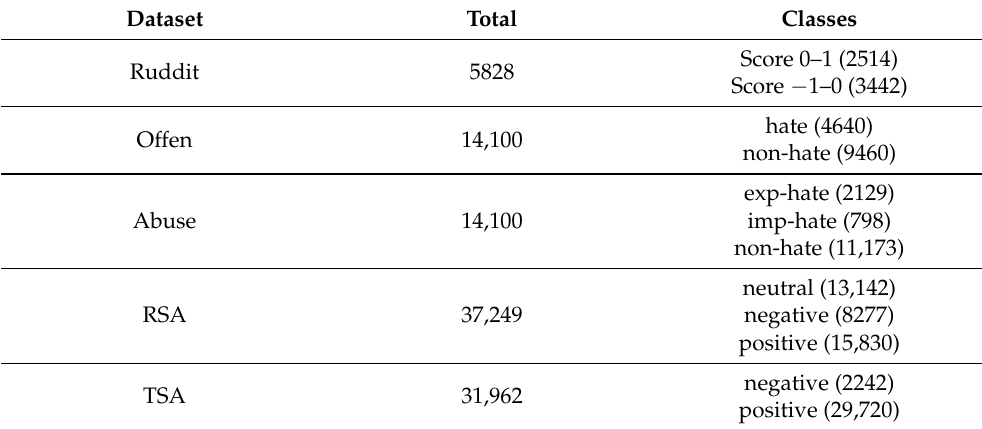
Table 1. Statistics of three experimental